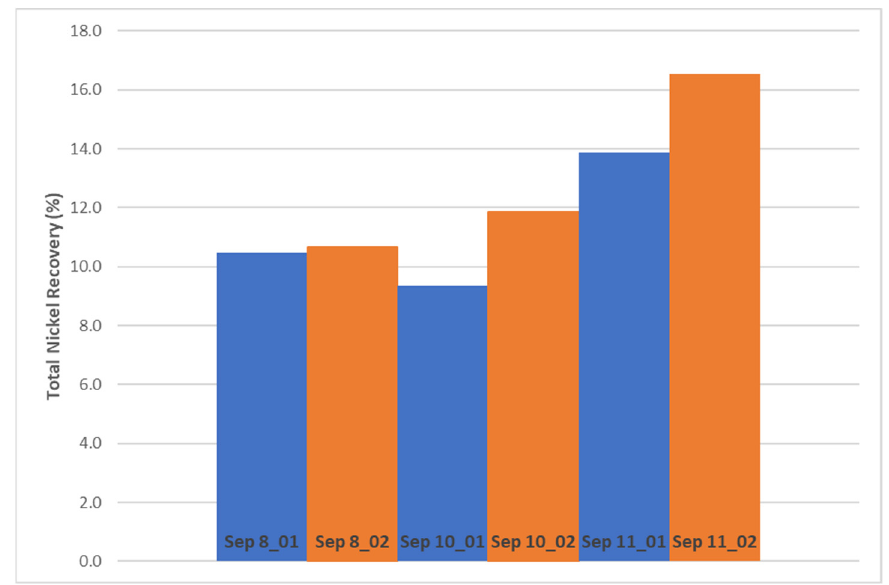
Figure 4. Total nickel recovery to Ni rougher-scavenger concentrate using process water without (01) and with (02) DAF treatment.